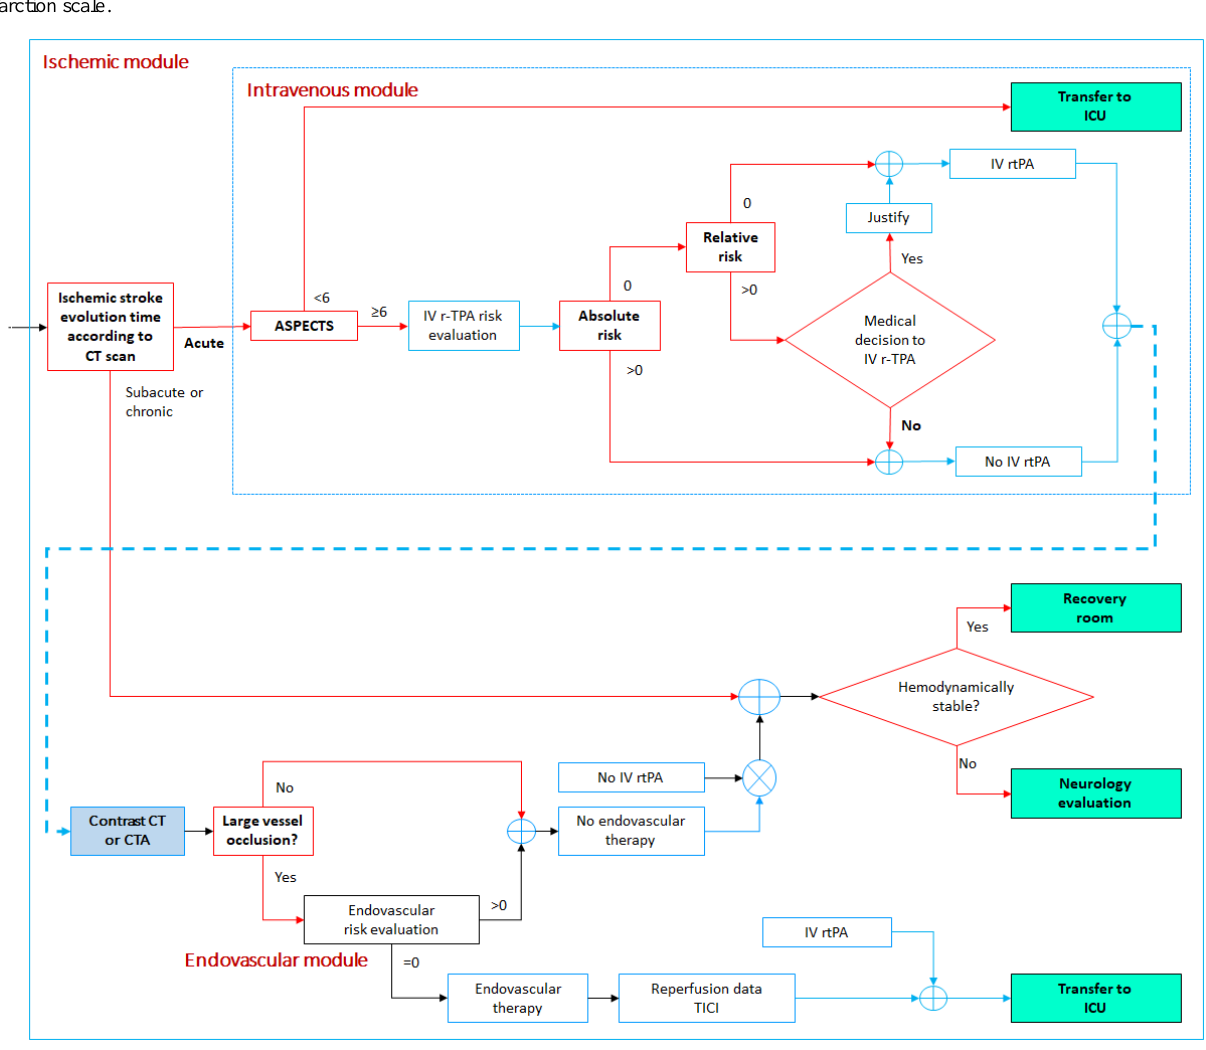
Figure 9. Ischemic module. ASPECTS: Alberta Stroke Program Early Computed Tomography Scan; CT: computed tomography; CTA: computed tomography angiography; ICU: intensive care unit; IV rtPA: intravenous recombinant tissue plasminogen activator; TICI: Thrombolysis in Cerebral Infarction